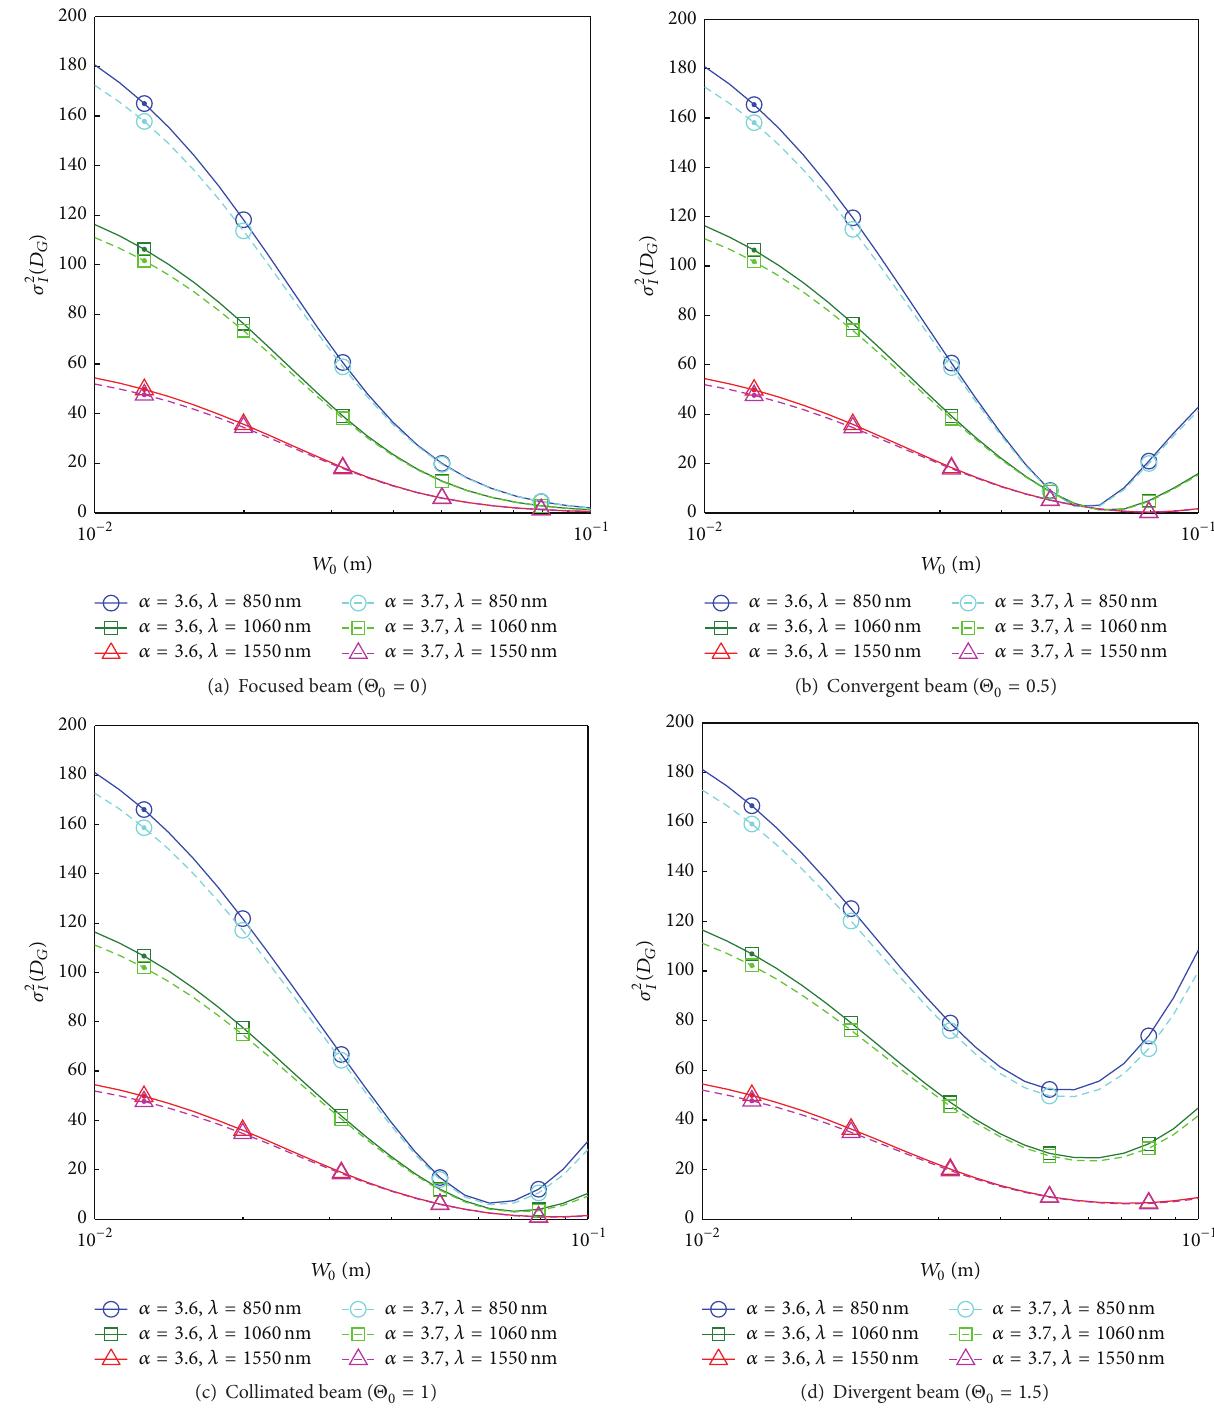
Figure 2: 𝜎 2 𝐼 of different Gaussian beams as a function of 𝑊 0 for several pairs of 𝛼 and 𝜆 .